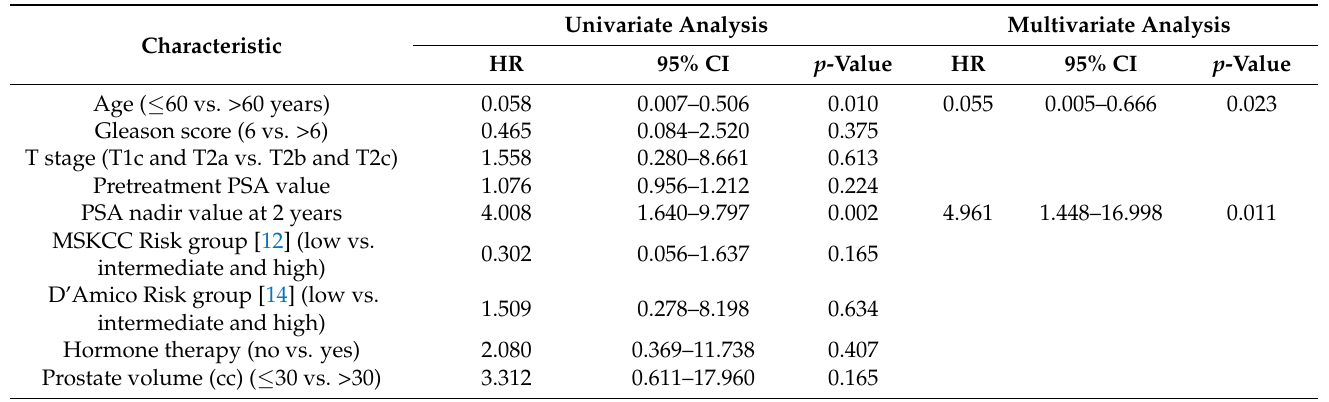
Table 3. The prognostic factors associated with large PSA